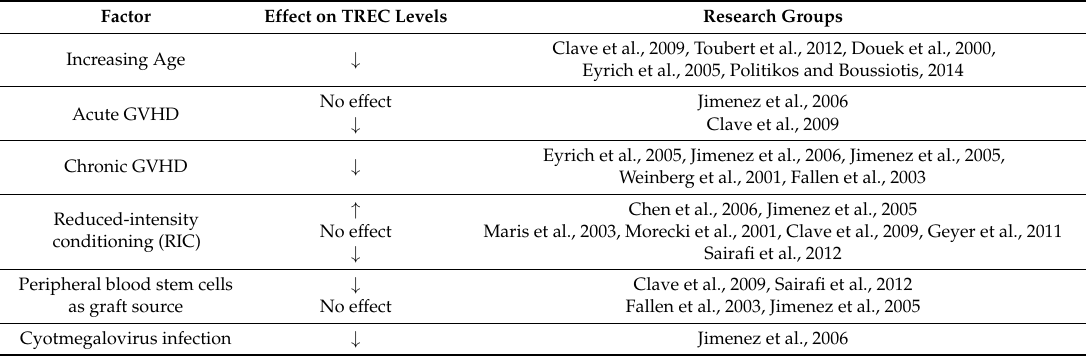
Table 2. Clinical factors influencing T cell receptor excision circles (TREC) level after hematopoietic stem cell transplantation